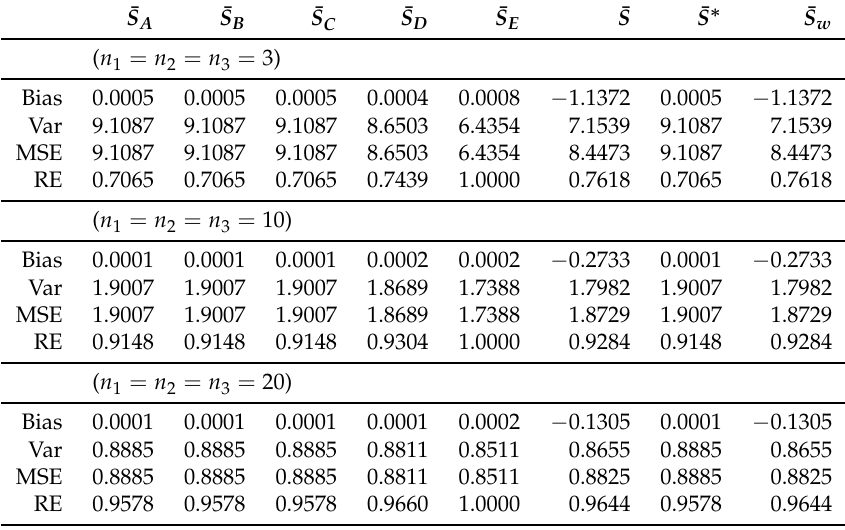
Table 1. The empirical bias, variance, MSE, and RE with an equal sample size.